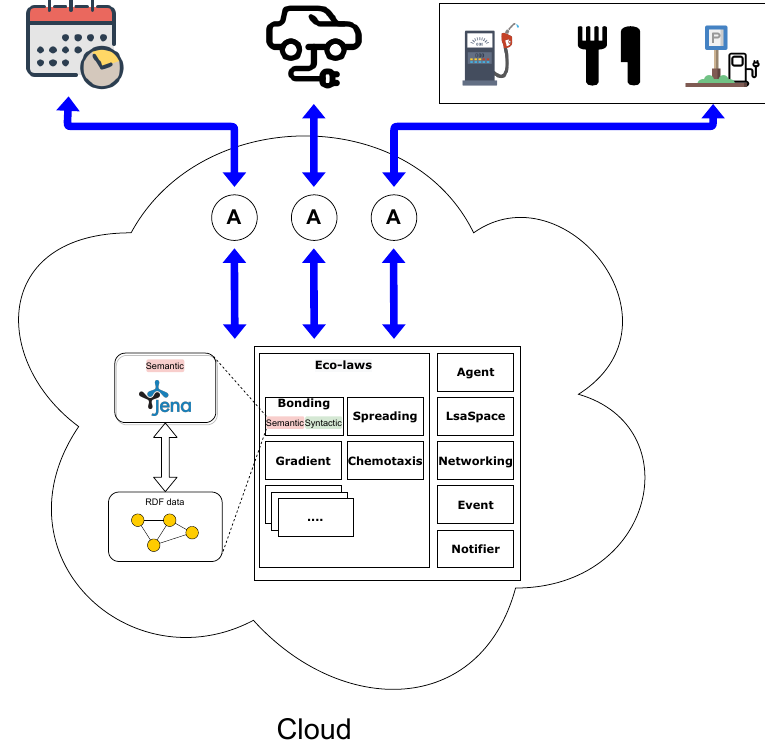
Figure 11. Deployment in the